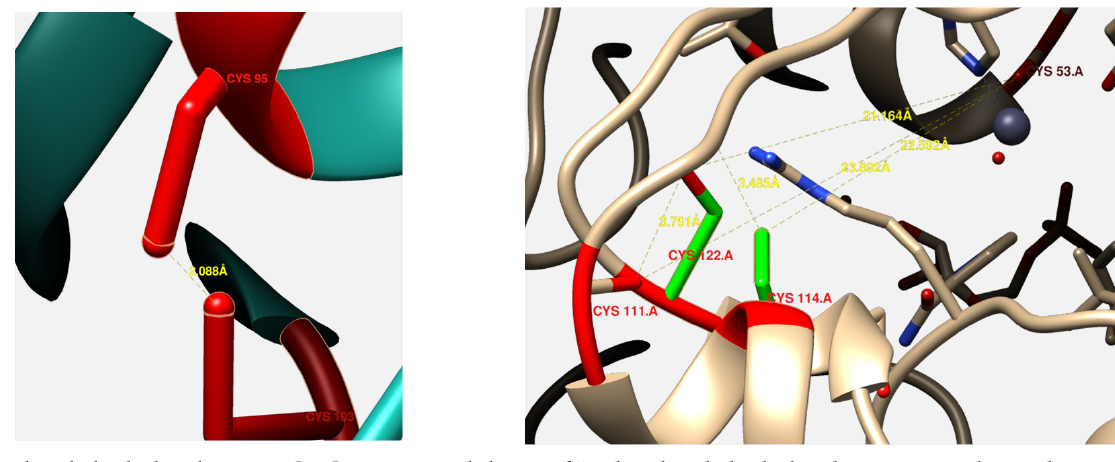
Figure 4. Comparison of the disulphide bridge in PCBG5HP1 and its homolog 3M6I. ( a ) The disul- phide bridge between Cys-95 and Cys-103 in PCBG5HP1. ( b ) The disulphide bridge between Cys- 53 and Cys-122, Cys-111, and Cys-114 in 3M6I homolog. 3.5. Pcbg5hp1, Pcbg5hp2, and Pcbg5hp12 mRNA Expression in P. cryoconitis BG5 under Heat- Shock and Cold-Shock Conditions The gene expressions of pcbg5hp1 , pcbg5hp2 , and pcbg5hp12 mRNA in P. cryoconitis